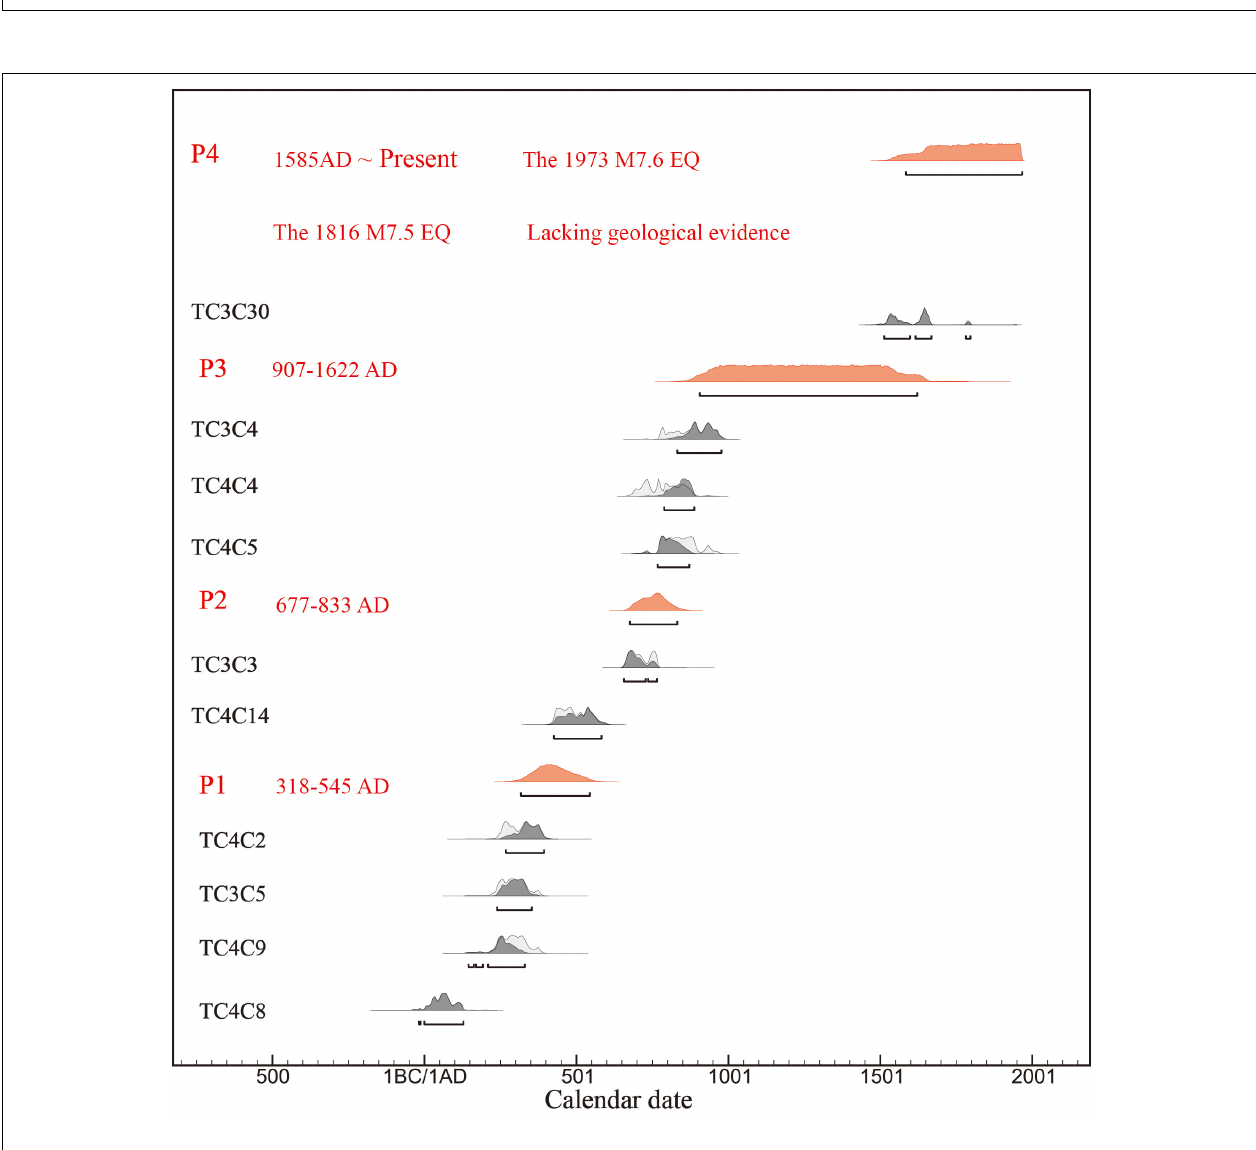
FIGURE 13 | Results of OxCal analysis of radiocarbon dates from site 2. The raw radiocarbon ages were calibrated by OxCal 4.3.1.